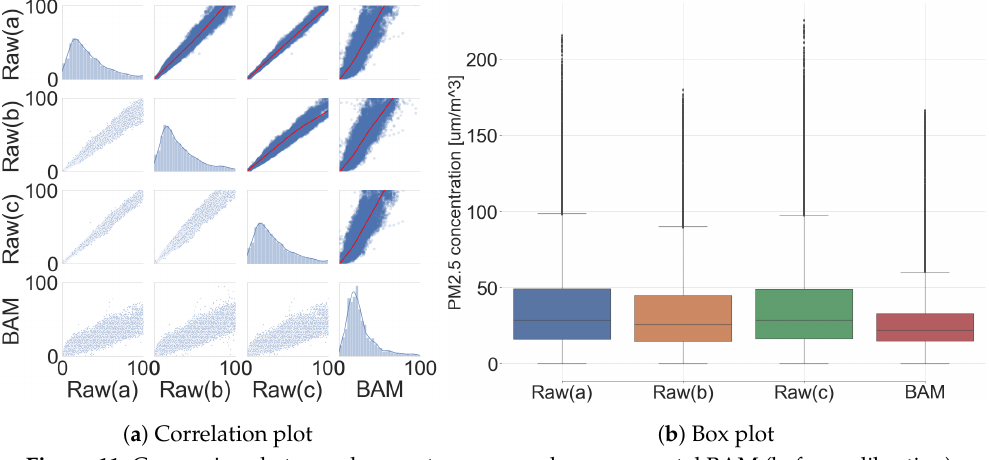
Figure 11. Comparison between low-cost sensors and governmental BAM (before